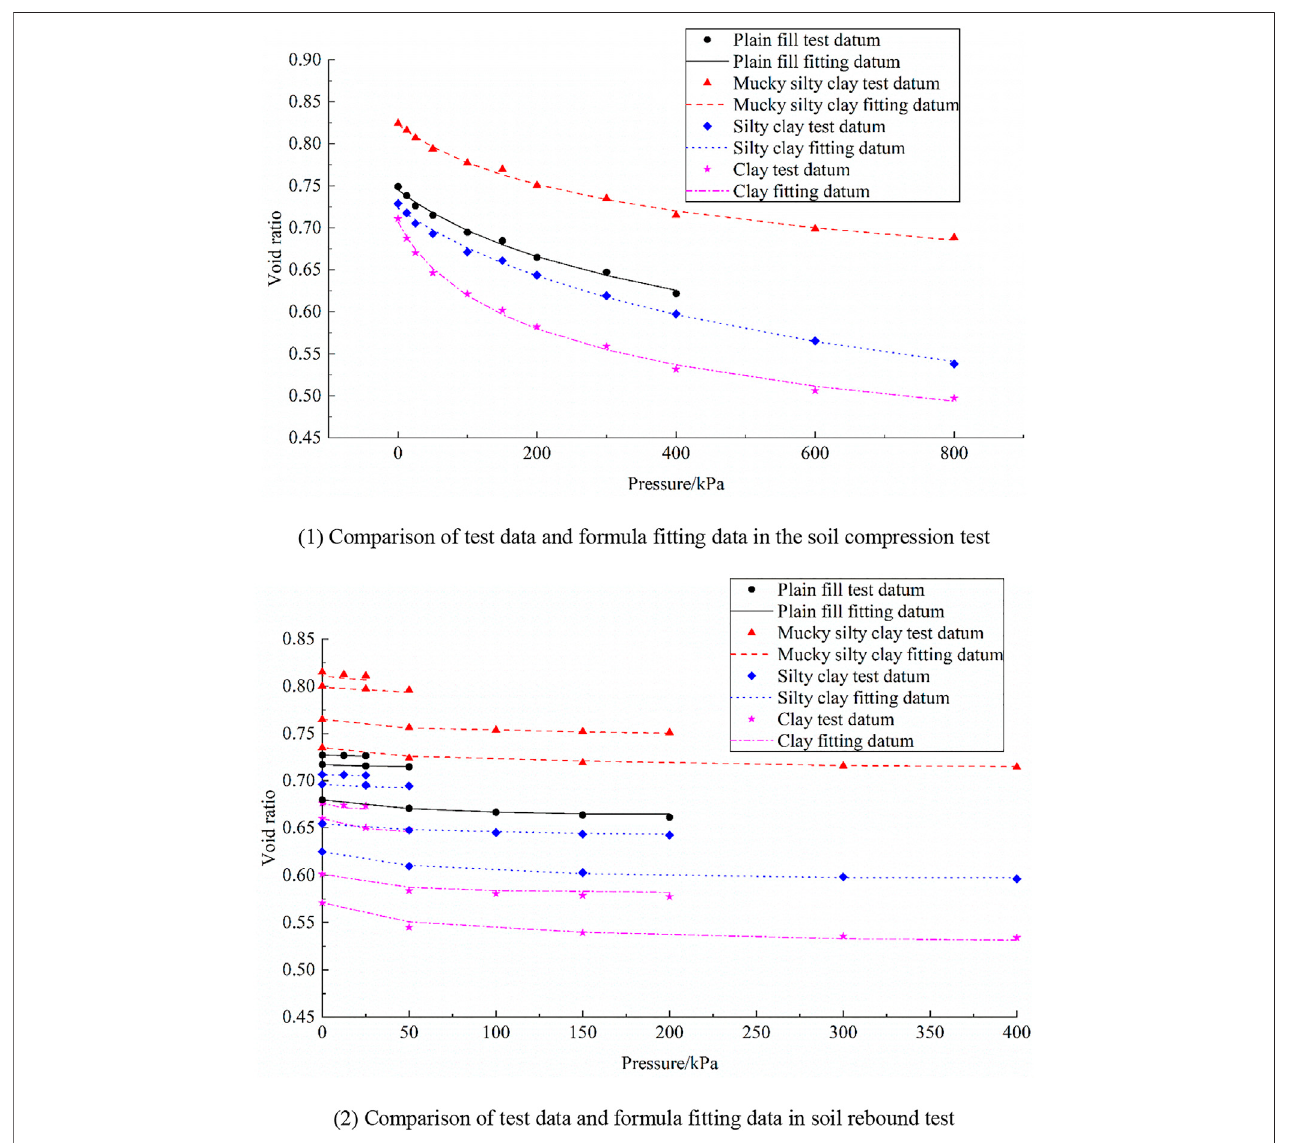
FIGURE 3 | Comparison of test data and formula fi tting data in soil compression-rebound